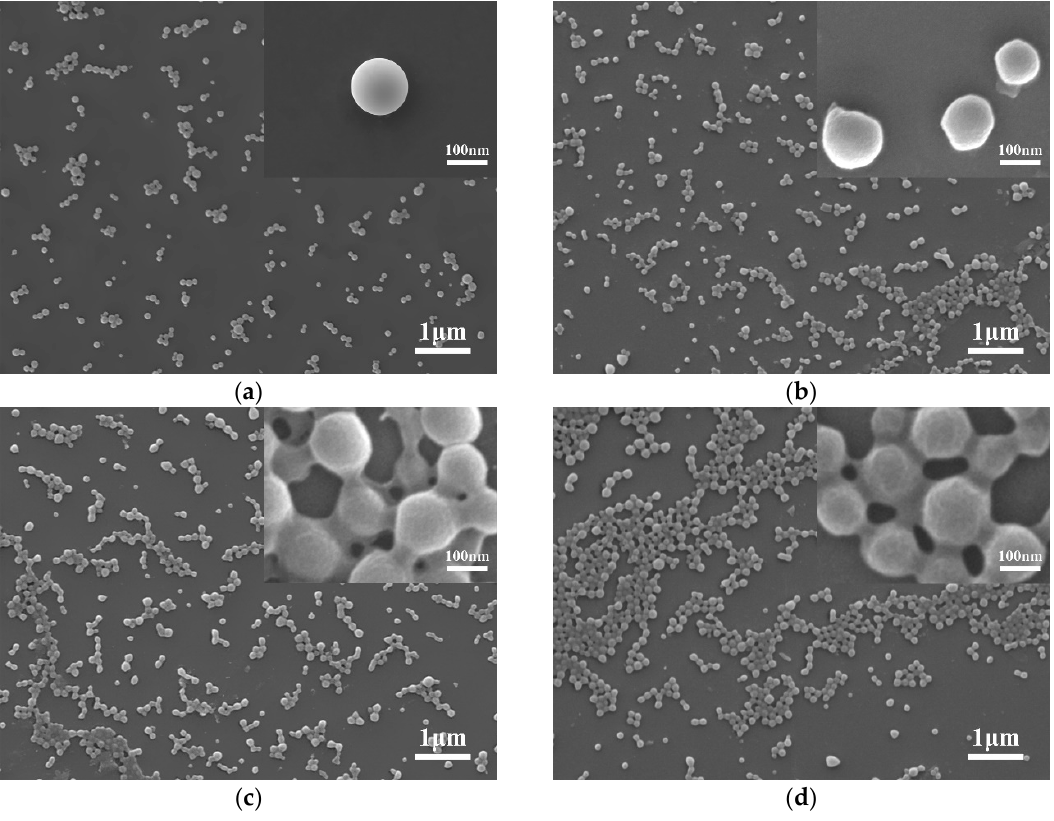
Figure 2. Scanning electron microscopy (SEM) images of the NPs: ( a ) poly (lactic- co -glycolic acid) (PLGA); ( b ) chitosan (CS)/PLGA=0.2; ( c ) CS/PLGA=0.4; ( d ) CS/PLGA=0.8;.